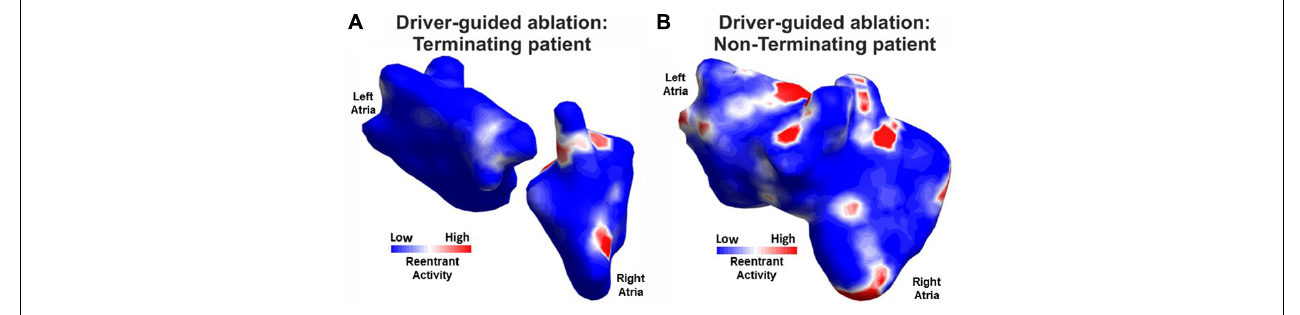
FIGURE 5 | Re-entrant activity cluster maps from driver-guided ablations in terminating (A) and non-terminating patients (B) (modified from Rodrigo et al.,